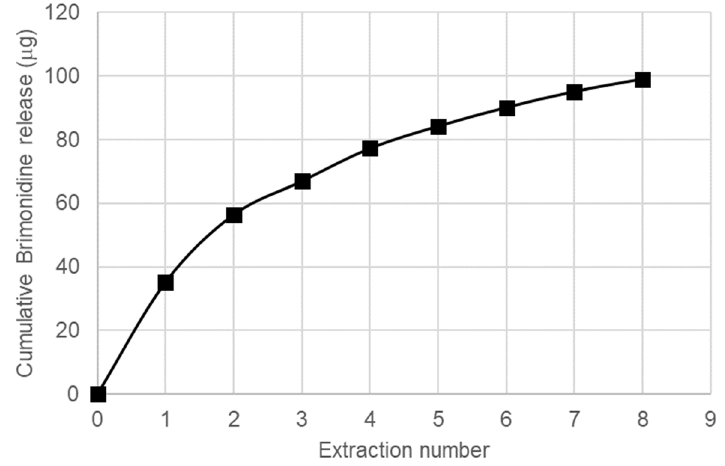
Figure 8. Cumulative release of BRI from BRI/LAP to the model of vitreous humour.